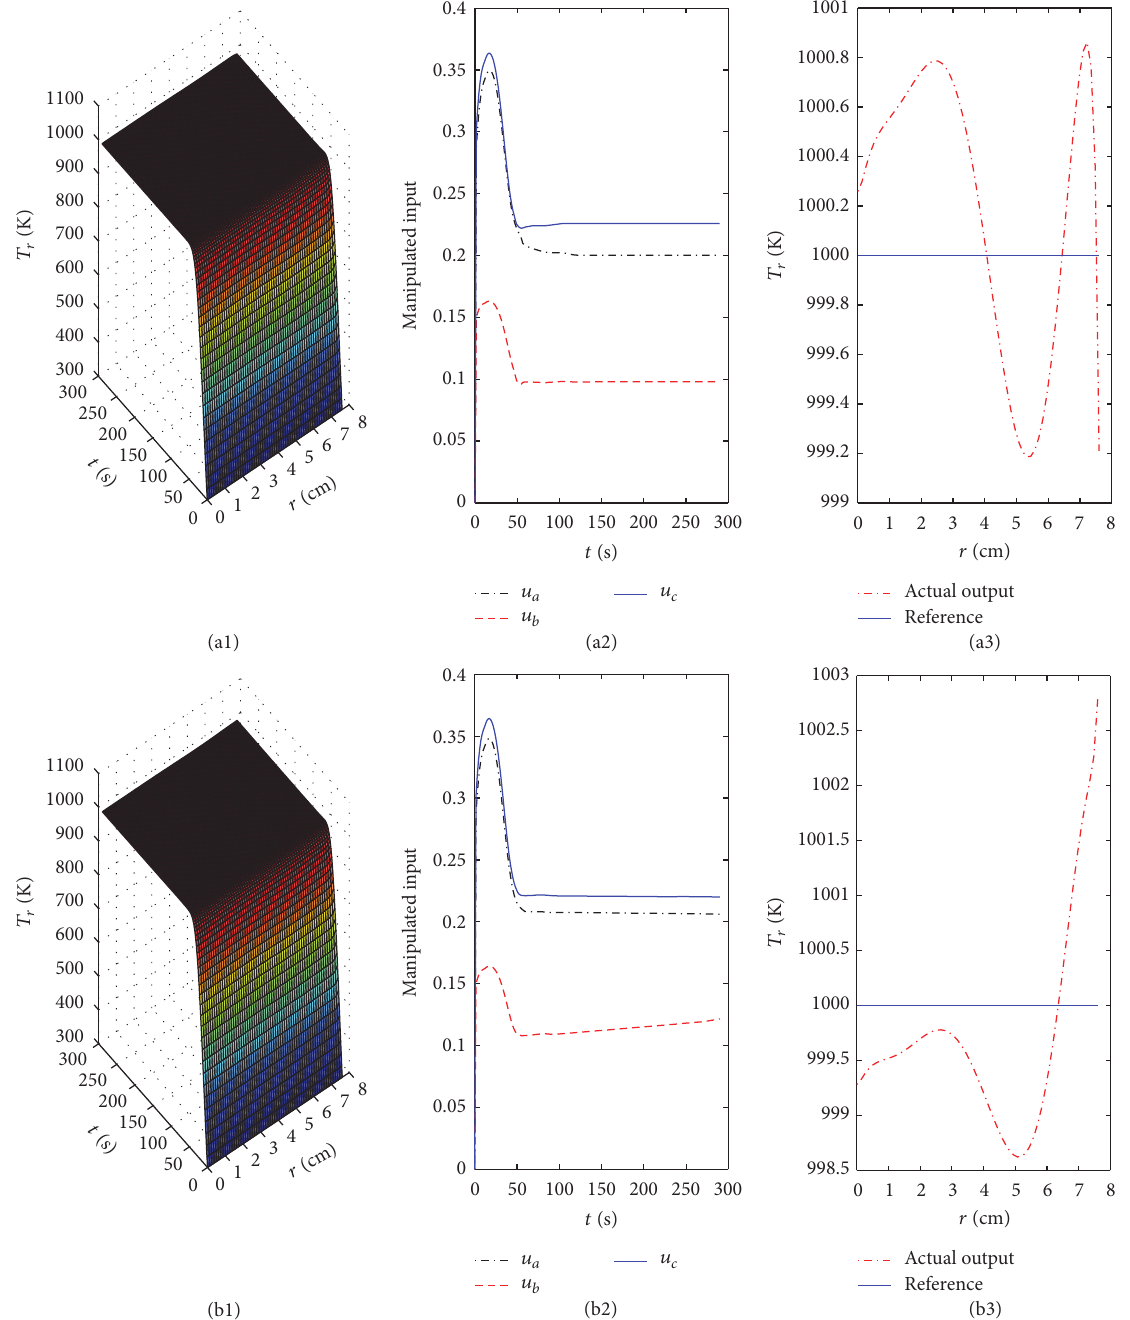
Figure10:Controlperformancecomparisonswithdifferentsensorplacementschemes:(a1)–(a3)usingproposedsensorlocations(sixoptimal locations); (b1)–(b3) using nine evenly distributed sensor locations. ( ∗ 1) denotes wafer temperature evolution profile, ( ∗ 2) denotes three